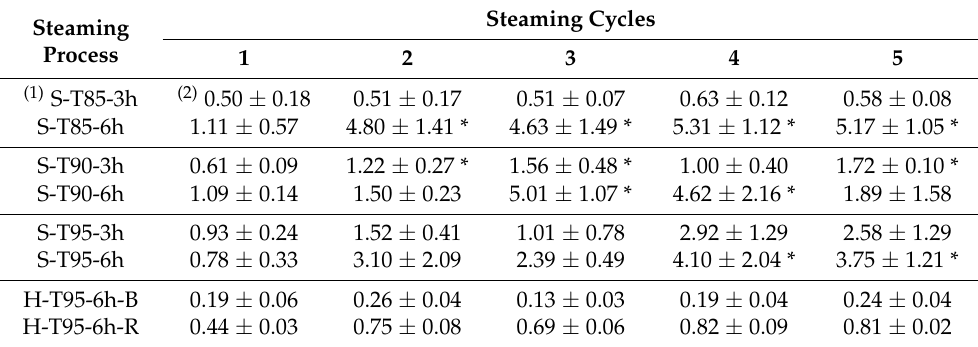
Steaming Cycles